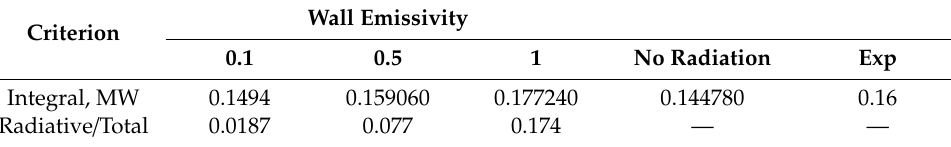
Figure 31. Segment average heat flux distribution. Table 4. Influence of radiation and wall emissivity.